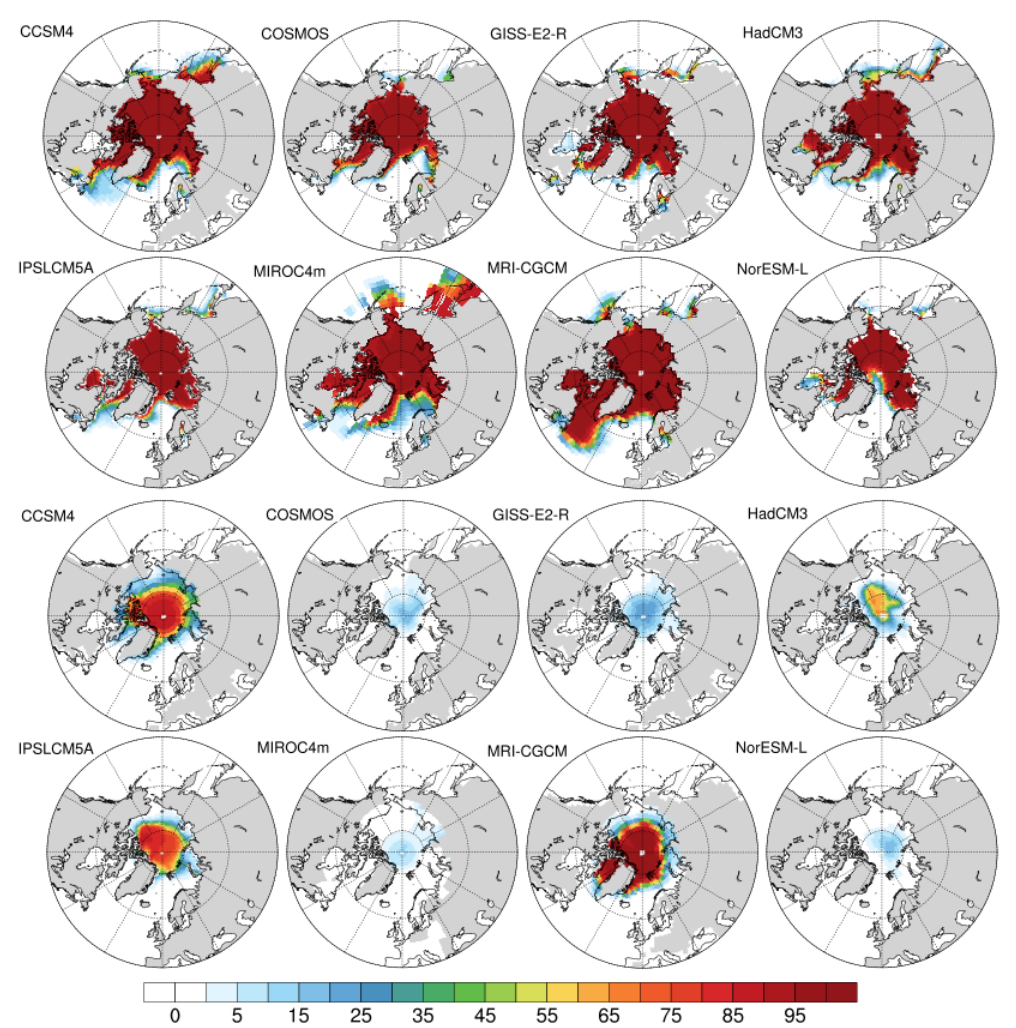
Figure 5. Mean sea ice concentrations (%) for winter (FMA, upper half) and summer (ASO, lower half) in the mid-Pliocene simulations for each PlioMIP Experiment 2